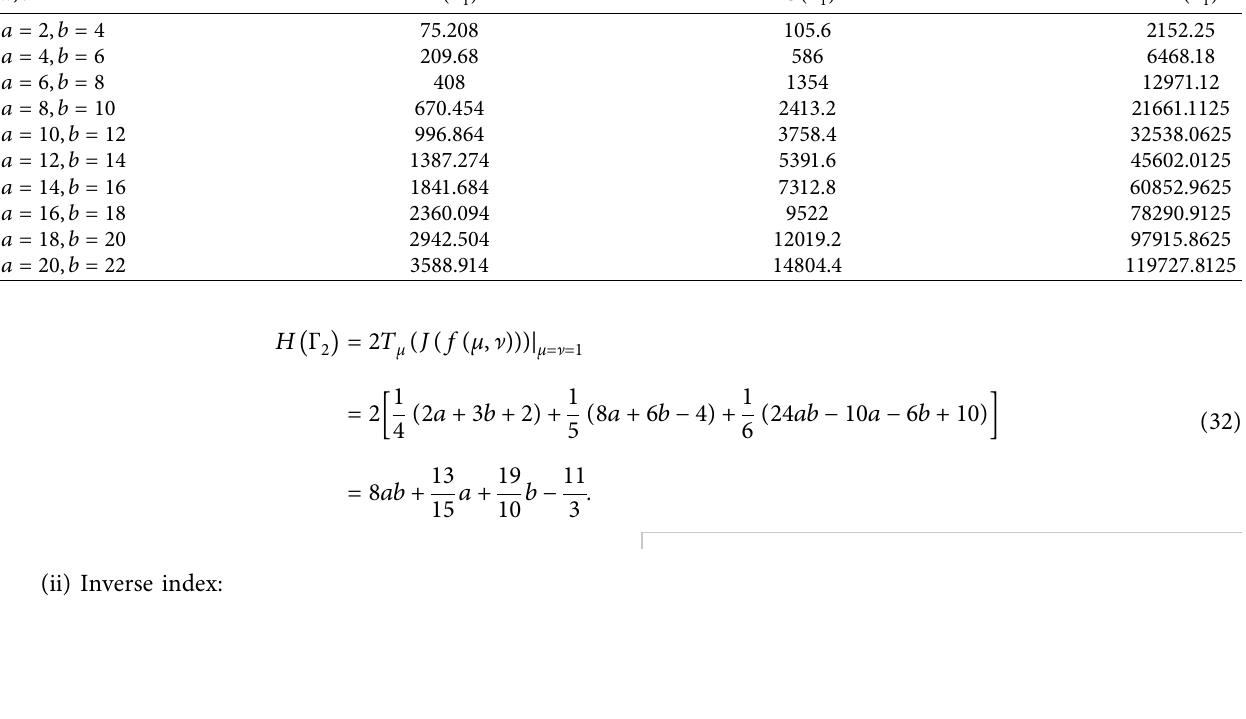
Table 7: Comparison between H ( Γ